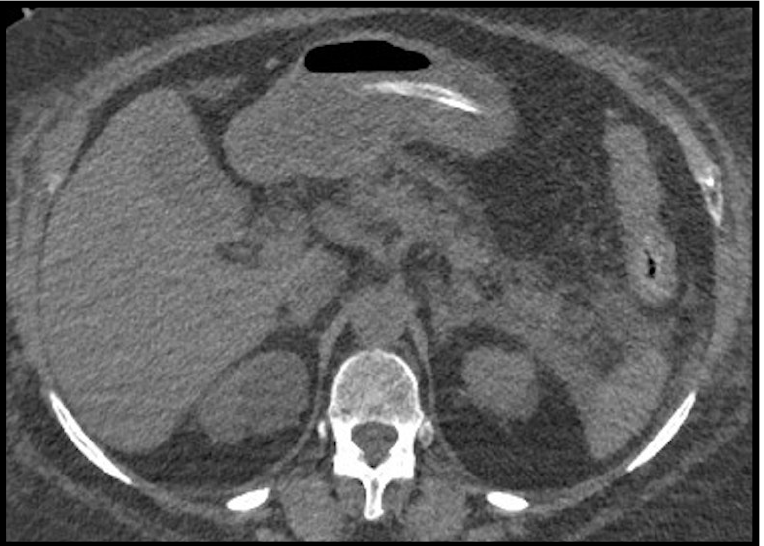
Figure 13. Pancreatitis. Enlarged and edematous pancreas especially at the head, with fat stranding and peripancreatic fluid collection extending along the left anterior pararenal space.